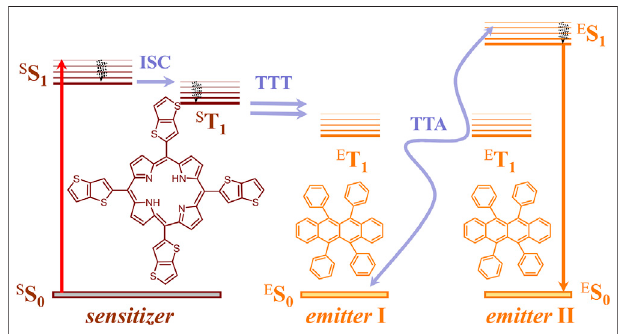
FIGURE 1 | Simpli fi ed energetic scheme of the TTA − UC process in the multicomponent organic system in a molecular oxygen-free environment. Left — structures of the sensitizer (TTP, meso -5,10,15,20-tetrathieno[ 3,2-b ] thienyl porphyrin) and right — structure of the emitter (rubrene).